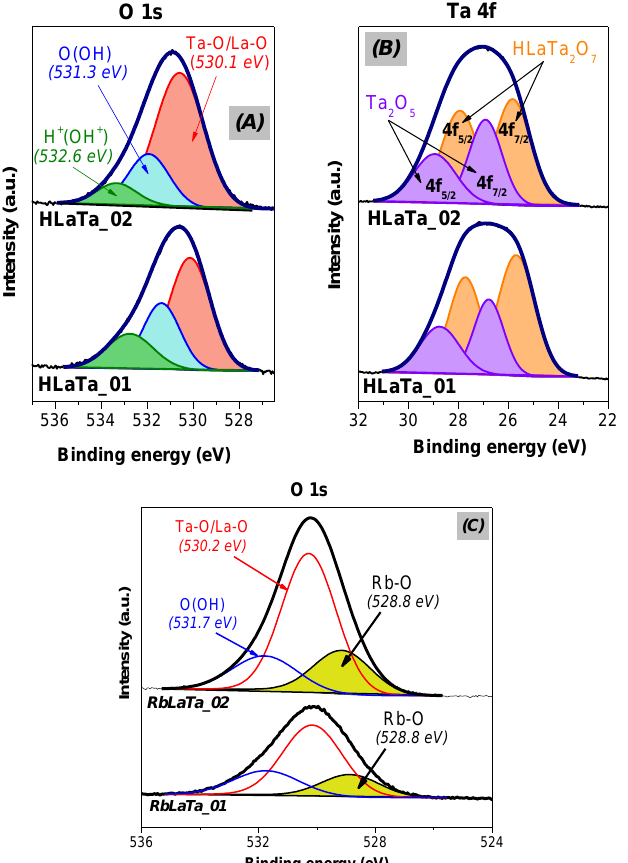
Figure 9. XPS spectra of HLaTa_01(02) protonated products for ( A ) O 1s and ( B ) Ta 4f emission lines. The O 1s spectrum of RbLaTa_01(02) starting materials ( C ) showing the presence of Rb-O species, is given. Reprinted with permission from reference [8]. Copyright (2019) Elsevier.